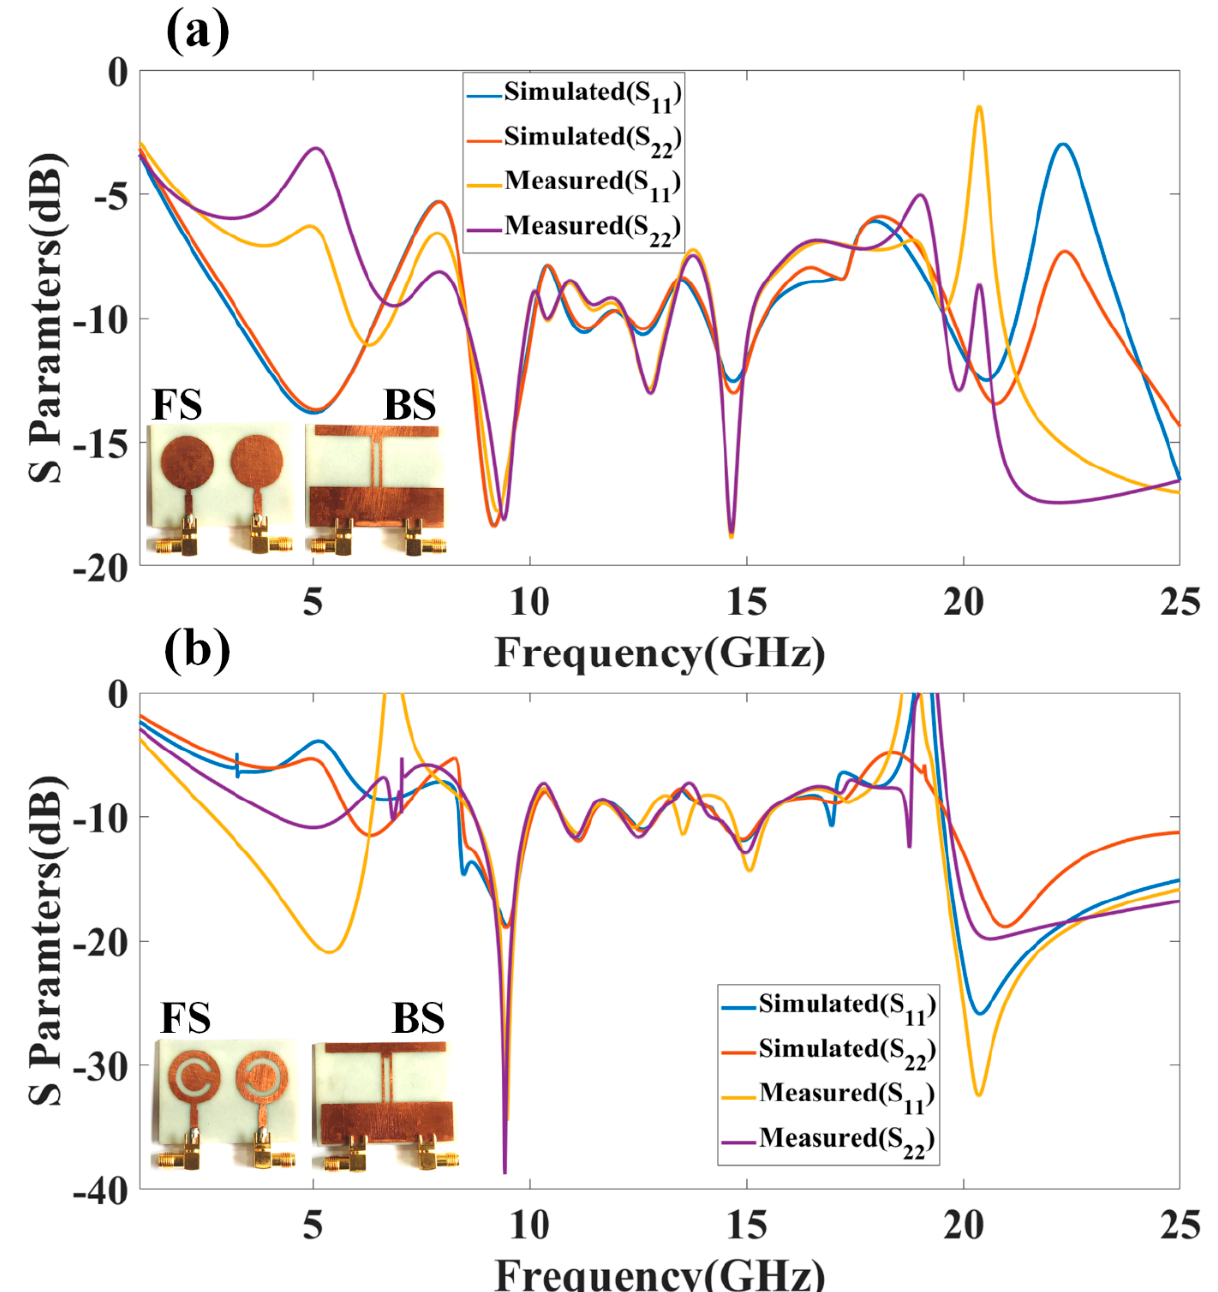
Figure 10. Comparative plot of simulated and measured reflectance loss factors (S 11 , S 22 ) (in dB) for ( a ) design 1 and ( b ) design 2 of the proposed structure of the antenna.